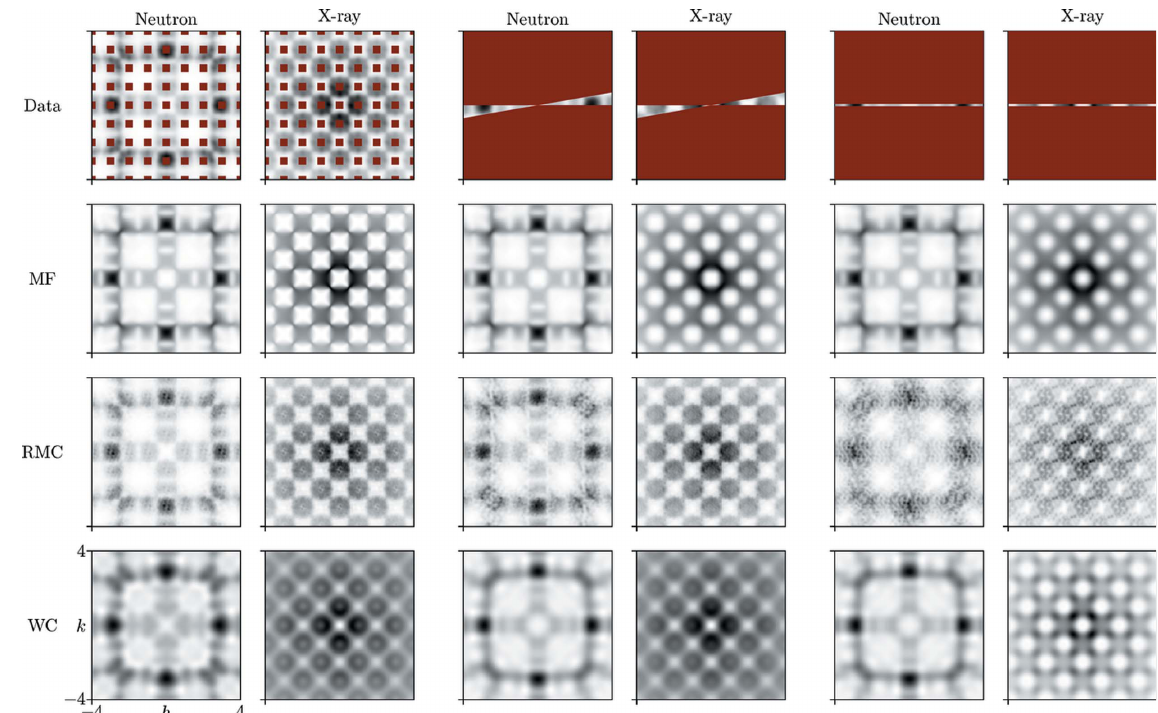
Figure 7 Refinements for missing data input. The top row shows the data input for the three different cases for both neutron and X-ray diffuse scattering: (left) the omission of scattering intensities close to the Bragg reflections, (middle) restriction of the data to a 10 (cid:9) wedge and (right) the 1D h 0 cut. Omitted data are indicated by magenta blocks. Rows two to four show the complete diffuse scattering as recovered from the refinements to the restricted data input for the MF refinement (row two), RMC refinement (row three) and WC refinement (bottom